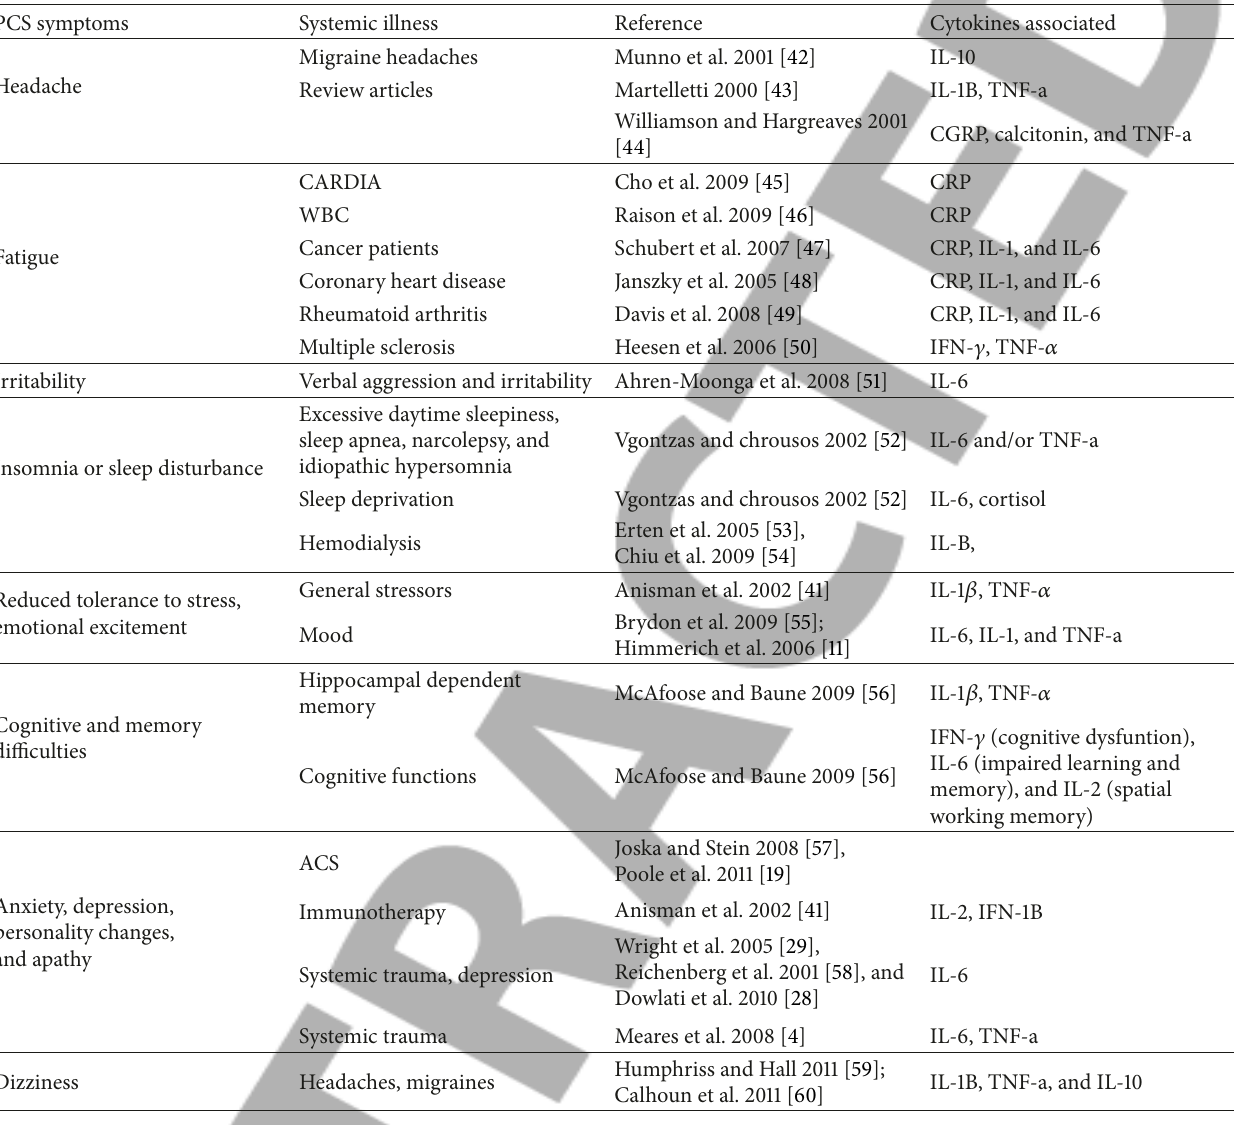
Table 3: The PCS symptoms explained based on the